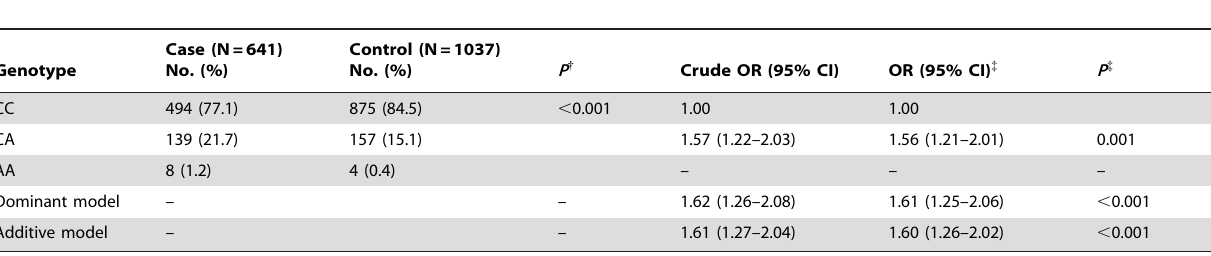
Table 2. Association between rs961253 and colorectal cancer risk in a Chinese population.